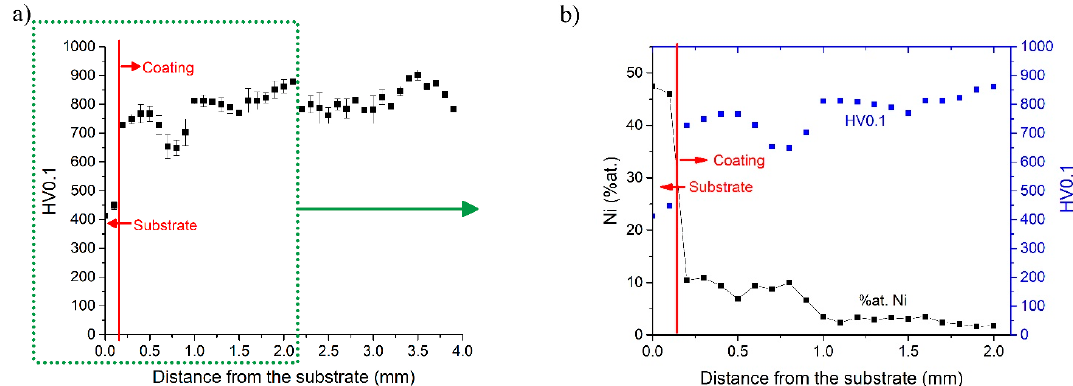
Figure 9. ( a ) Microhardness distribution of the T-800 coatings deposited on RENE 77 using the LENS process. ( b ) Microhardness distribution and Ni content in sample 18.